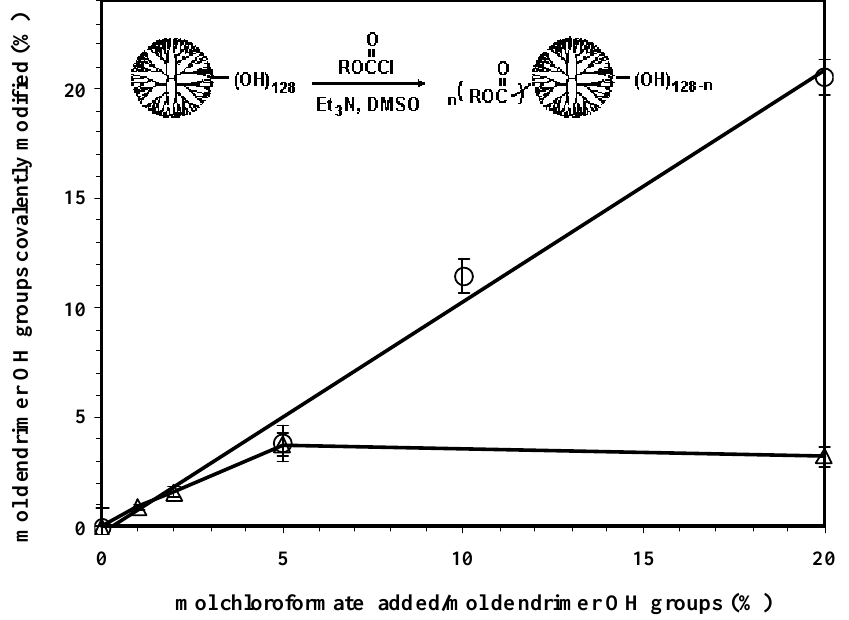
Figure 1. Partially hydrophobic modification of the G cholesteryl ( Δ ) chloroformate (the percentage of hydroxyl groups hydrophobized was determined by the NMR ratio of the resonance of dodecyl methyl proton at 0.83 ppm or cholesteryl = CH 6 proton at 5.3 ppm to the corresponding dendrimer nucleus NH proton at 7.78